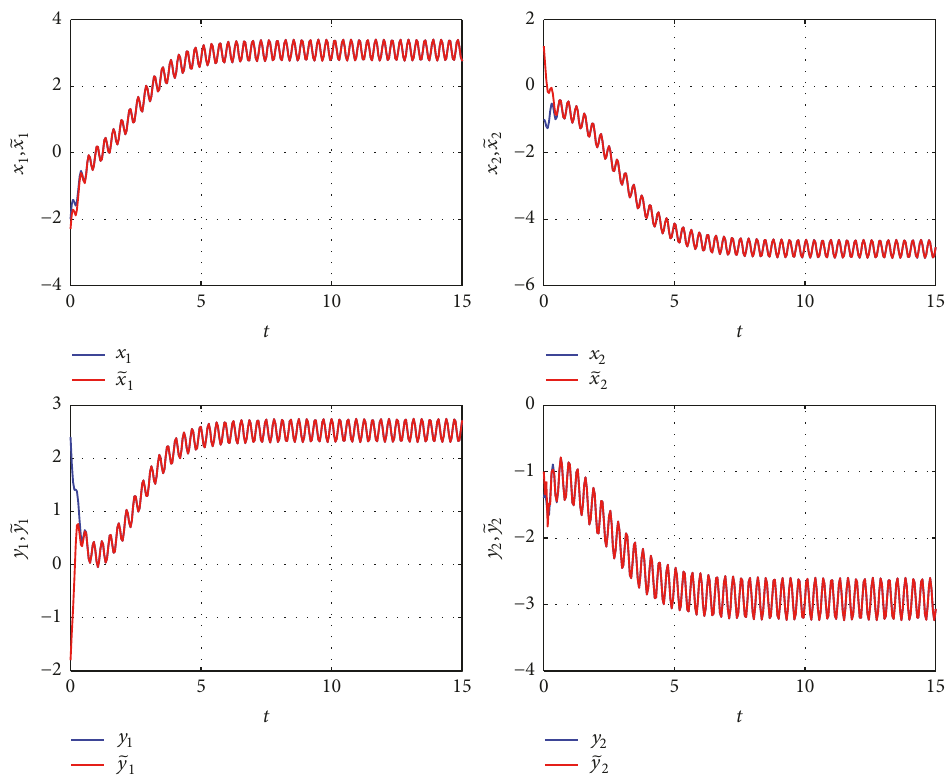
Figure 3: Synchronization curves of real and imaginary parts of 𝑧 1 , 𝑧 2 , ̃𝑧 1 , and ̃𝑧 2 under controller for example 1.